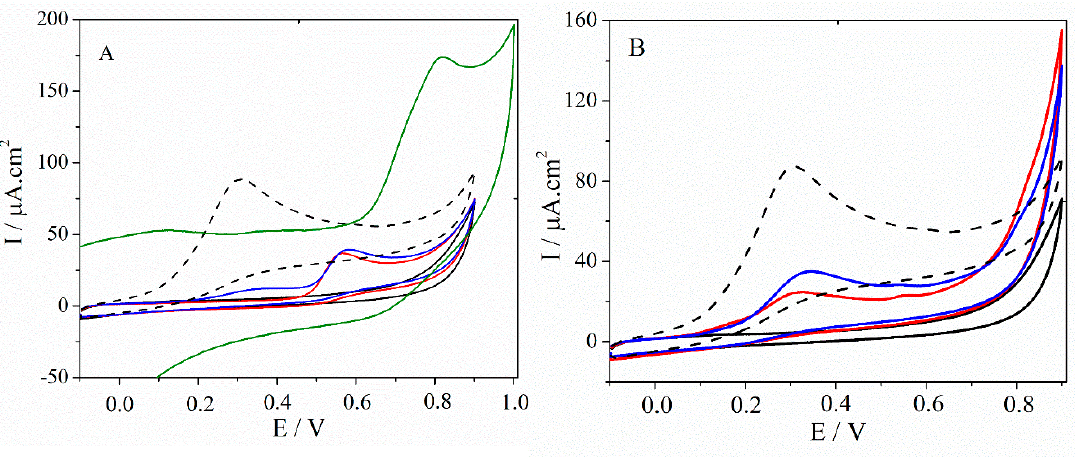
Figure 3. Cyclic voltammograms for culture broth components: ( A ) PBS (black), culture broth (red), culture broth + NADH 0.1 mmol · L − 1 (blue), yeast 10 g · L − 1 (green), and NADH 1.0 mmol · L − 1 (dashed line); and ( B ) glucose kit components: PBS (black), commercial kit (red), kit + NADH 0.1 mmol · L − 1 (blue), and NADH 1.0 mmol · L − 1 (dashed line). Conditions: pH = 7, scan rate 0.1 V · s − 1 .